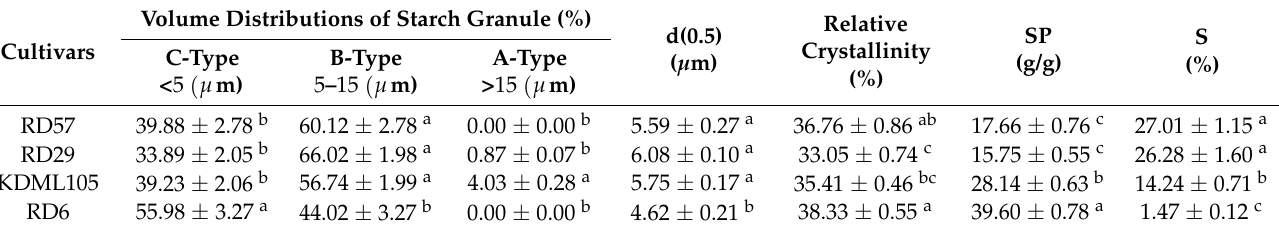
Table 3. Granule volume distribution (%), median granule size [d(0.5)], relative crystallinity, swelling power, and water solubility of starch granules from the caryopses of four Thai commercial rice cultivars differing in starch pasting properties.